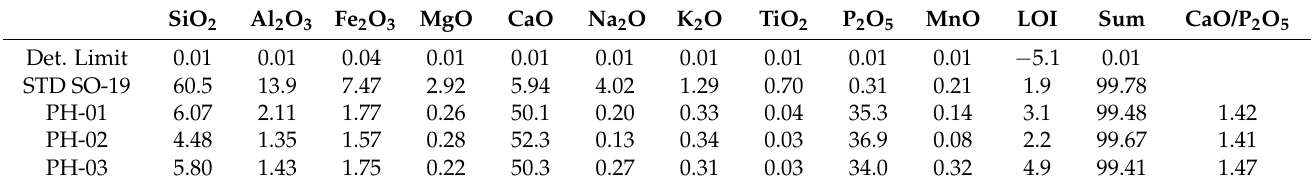
Table 1. Major oxide contents (%) of the phosphate nodule samples (DL: detection limit of ICP-MS). SiO